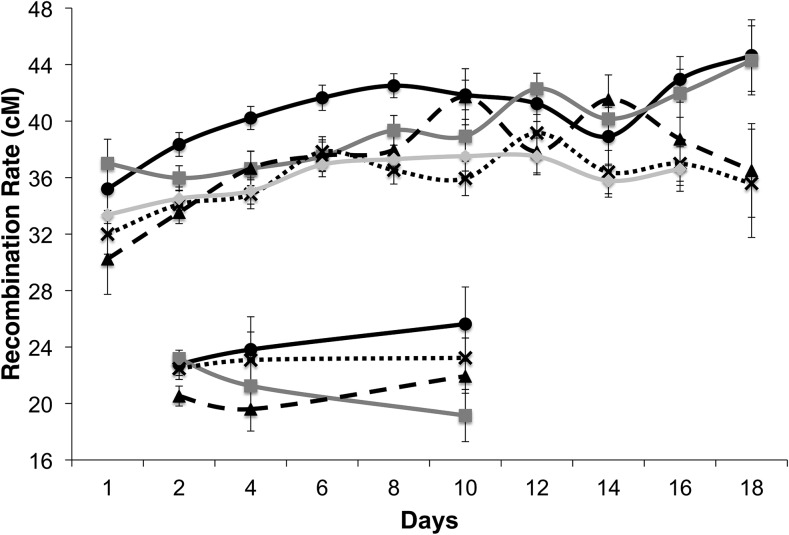
Average crossover frequency separated by day for RAL_21 (black line, ● data points), RAL_59 (dark gray line, ▪ data points), RAL_73 (long-dashed black line, ▴ data points), RAL_75 (short-dashed black line, X data points), and RAL_136 (light gray line, ♦ data points). Upper lines represent crossover frequency in the y v interval while lower lines represent crossover frequency in the e ro interval. Error bars denote standard error.